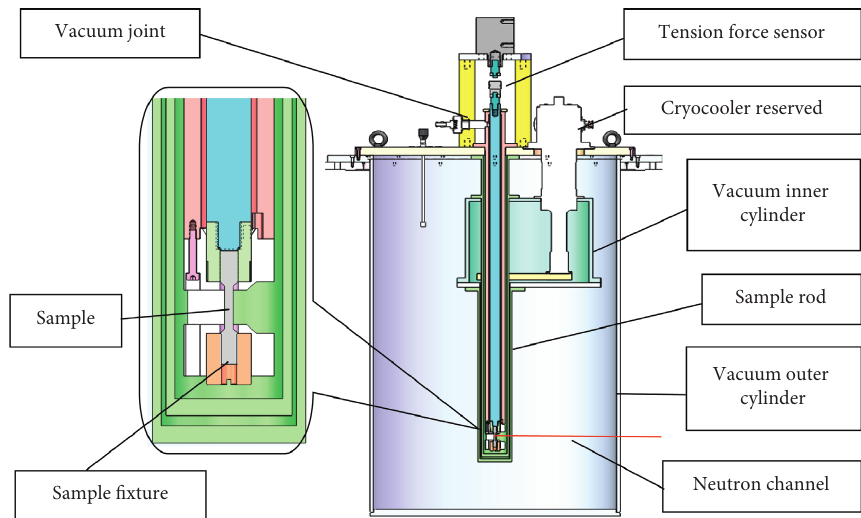
Figure 1: The structure of the in situ stretching sample